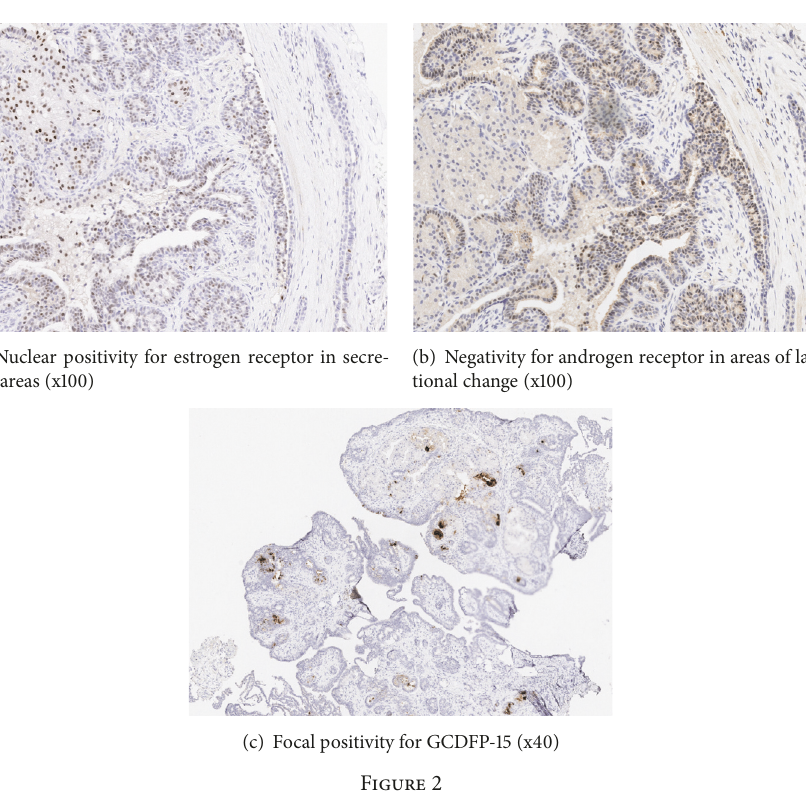
Table 1: Diagnostic terminology and histological features used to describe lesions arising from anogenital mammary-like glands. Study Diagnostic term Descriptive